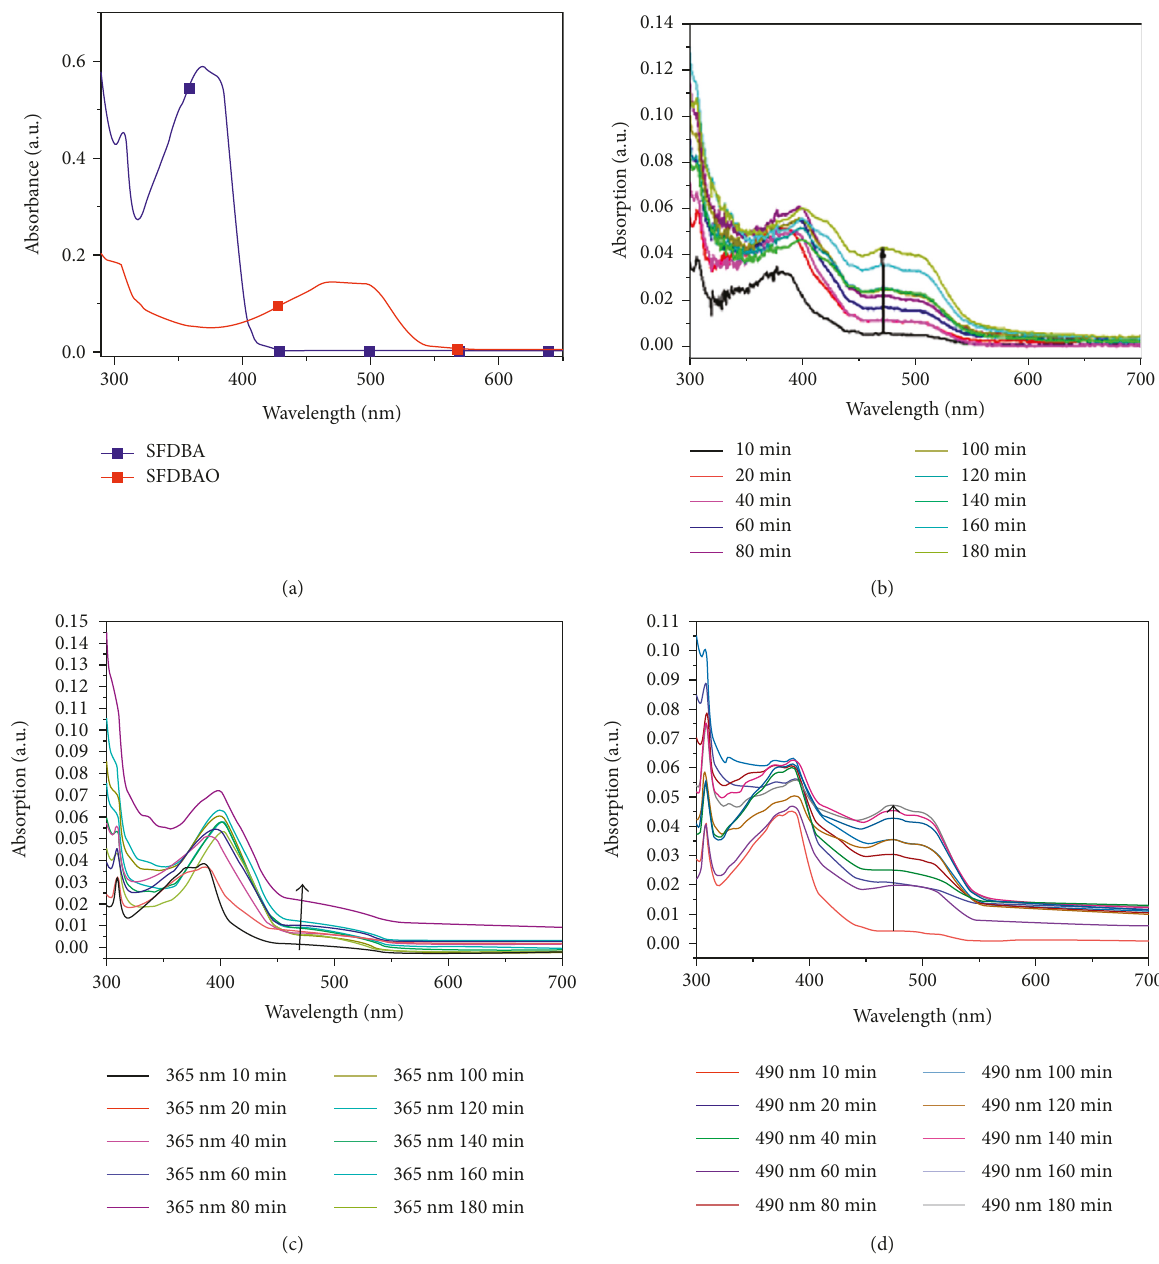
Figure 3: (a) The absorption spectra of SFDBA and SFDBAO. Absorption spectra of 1a at different reaction times: (b) under the sunlight, (c) under the 365nm UV lamp, and (d) under 490nm UV